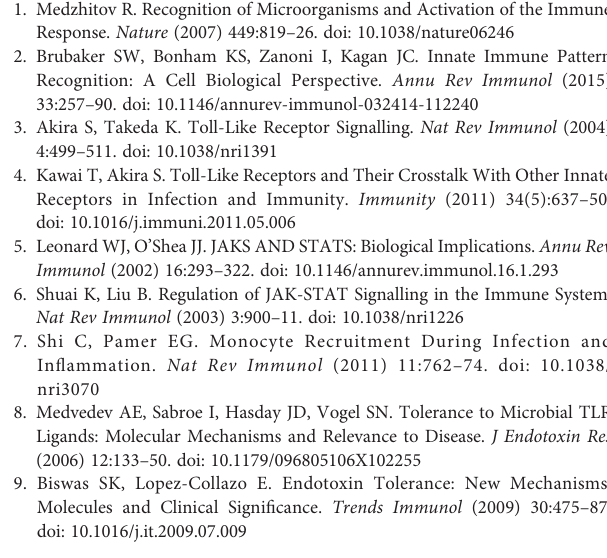
treated versus untreated (Ø) monocytes. NES and -log10(FDR) of transcription factors (TF) enriched on the Ø side are shown (FDR < 0.05). (E) Barplot of genomic features as percentages of C1-, C2- and C3-associated CpGs (Figure 2H) compared with total hypo-methylated CpGs. (F) Accessibility (ATAC-seq) data of CpGs associated with C1 (in red), C2 (in blue) and C3 (in green) after 1, 4 and 24 hours of monocyte culture with LPS. Public ATAC-seq data were used [15] Supplementary Figure S3 | Additional characterization of JAK2 inhibition in LPS-treated monocytes. (A) Western blot of JAK2-dependent STAT proteins in LPS-treated and untreated (Ø) monocytes, with and without JAK2 inhibitor (iJAK2) after 4 hours (left) or 96 hours (right) of treatment. LaminB was used as the loading control. (B) TNF a and IL-10 levels measured in cell supernatants to assess the tolerance state after JAK2 inhibition. Supplementary Figure S4 | DNA methylation alterations in CD14 ⁺ monocytes from Gram-negative sepsis. (A) Differentially methylated positions (DMPs) found in the comparisons of Gram ⁻ sepsis (SEP), other sepsis and SIRS patients with healthy donors (HD) (FDR < 0.05). (B) DNA methylation heatmap of differentially methylated CpGs comparing all groups shown pairwise (FDR < 0.05). Scaled and batch-corrected b -values are shown, ranging from -4 (lower DNA methylation levels, blue) to +4 (higher methylation levels, red). On the right, violin plots of hypomethylated and hypermethylated clusters depicting normalized DNA methylation data. (C) Principal components 1 and 2 from a principal component analysis (PCA) of the DMPs from Supplementary Figure 4B are shown. (D) Bubble scatterplot of TF binding motif enrichment for Gram-negative hypomethylated CpGs. The x-axis shows the percentage ofwindows containing the motif; the y-axis shows the magnitude of enrichment of the motif. Bubbles are colored according to TF family. FDR is indicated by bubble size (selected TF with FDR ≤ 0.05). (E) GO (Gene Ontology) over-represented categories in the Gram-negative hypomethylated CpGs. The fold change relative to the background (EPIC array CpGs) and -log10(FDR) is shown. (F) Violin plot of normalized b values of the Gram- negative Hypomethylated CpGs in untreated monocytes (Ø), LPS-treated monocytes and P3C-treated monocytes (277